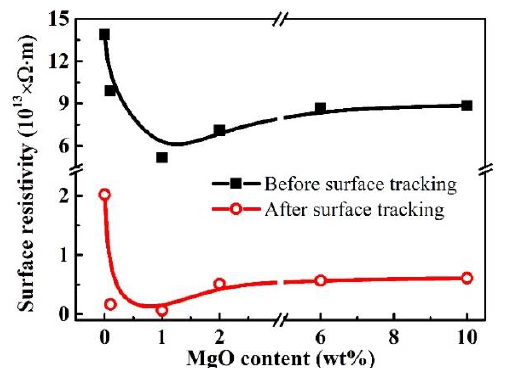
Figure 7. Surface resistivity of the nano-MgO/epoxy composite samples, before and after surface tracking